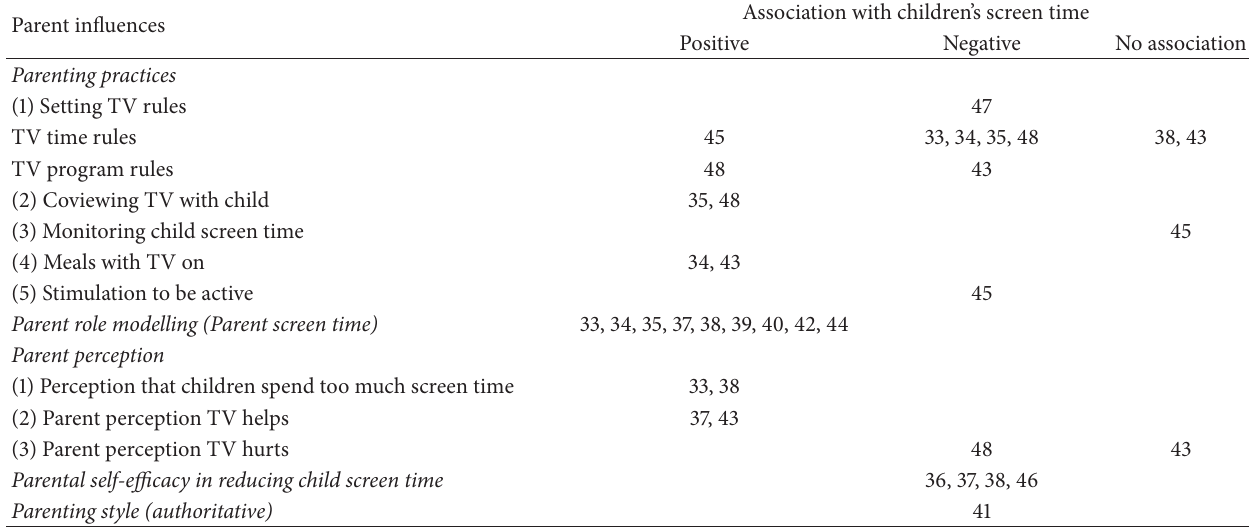
Table 6: Papers reporting an association between parental influences and children’s screen